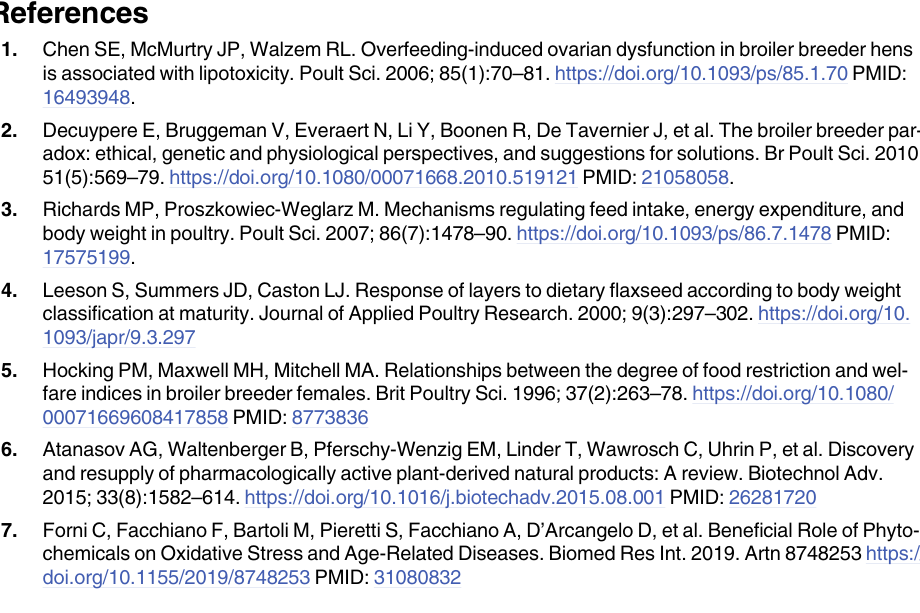
S1 Table. Composition of the diet for the different groups of animals. A: control without supplementation, B and C: supplementation at 0.5% and 1% of the total diet composition, respectively, starting at 4 week-old until 40 week-old (experiment 1), and D: supplementation at 1% of the total diet composition, starting at hatch until 40 week-old (experiment 2). S2 Table. Oligonucleotide primer